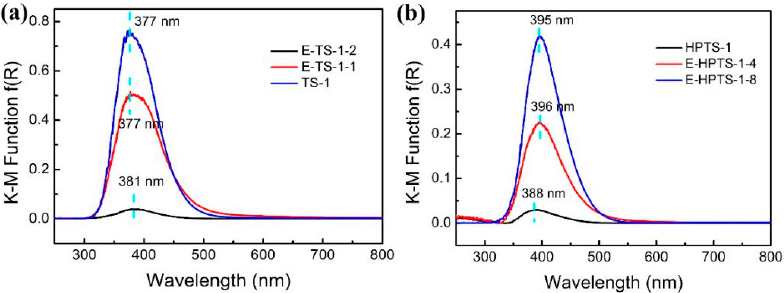
Figure 3. DRS UV-Vis obtained from (TS-1/CH 3 OH/H 2 O 2 − TS-1/CH 3 OH/H 2 O) of extruded TS-1 ( a ) and HPTS-1 ( b ) samples.